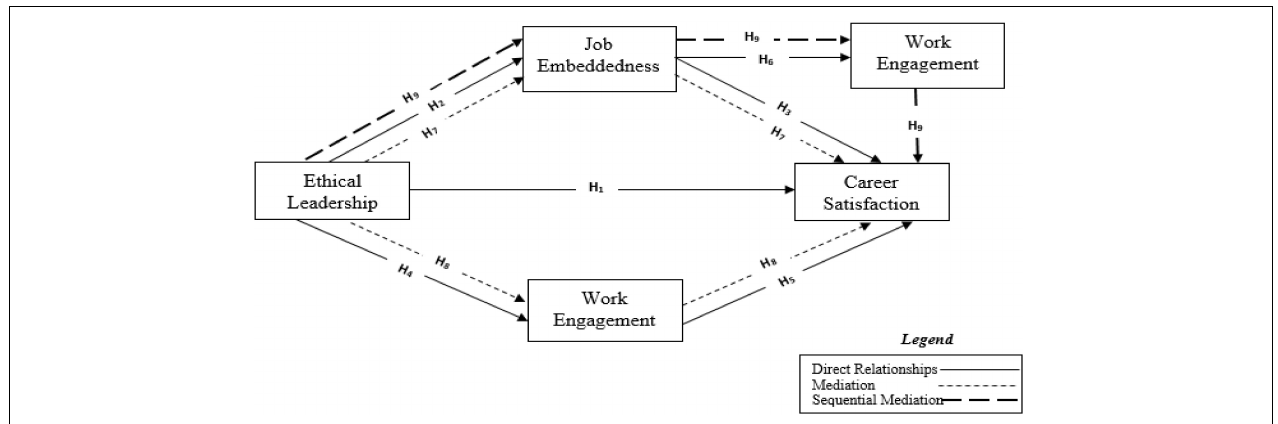
FIGURE 1 | The conceptual